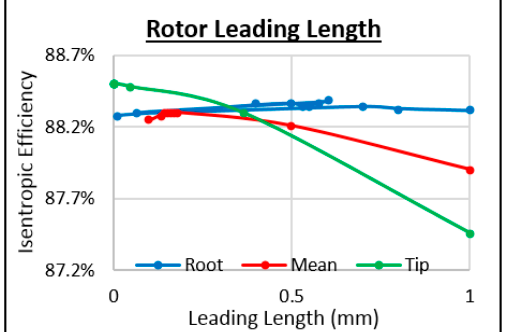
Figure 34. Study of the rotor leading length.